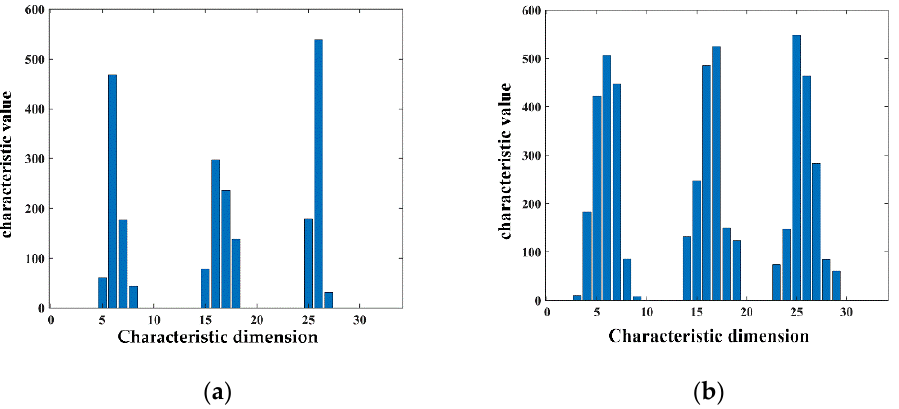
Figure 20. Comparison of FPFH and AGWF at a point. ( a ) The FPFH feature descriptor for a point. ( b ) The AGWF feature descriptor for a point.